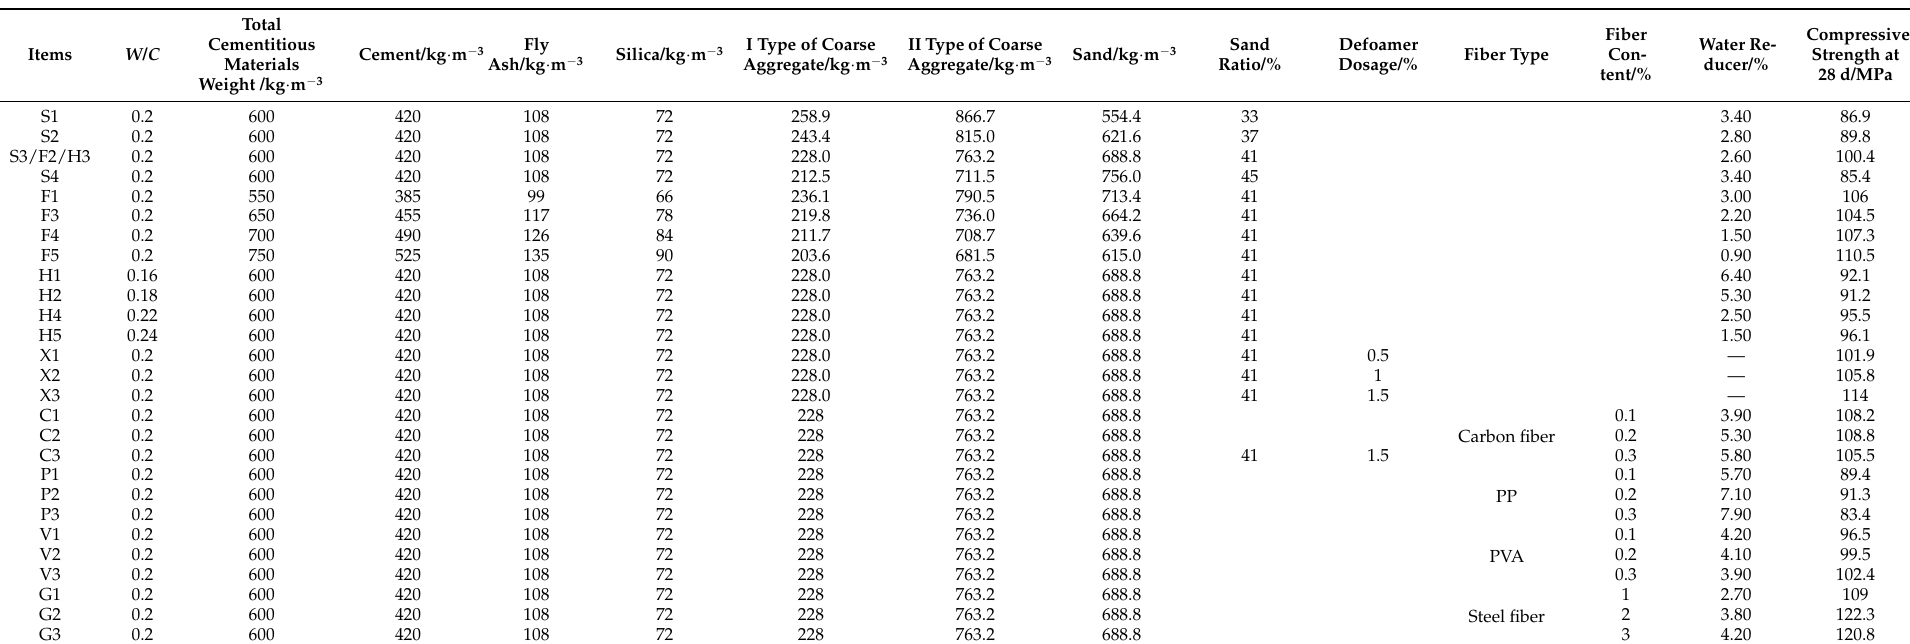
Table 2. The mix proportion design of